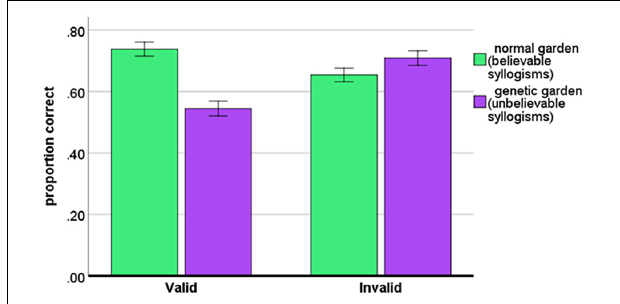
FIGURE 1 | Accuracy of syllogistic reasoning as the function of Validity and Believability. Error bars represent the standard errors of the mean.